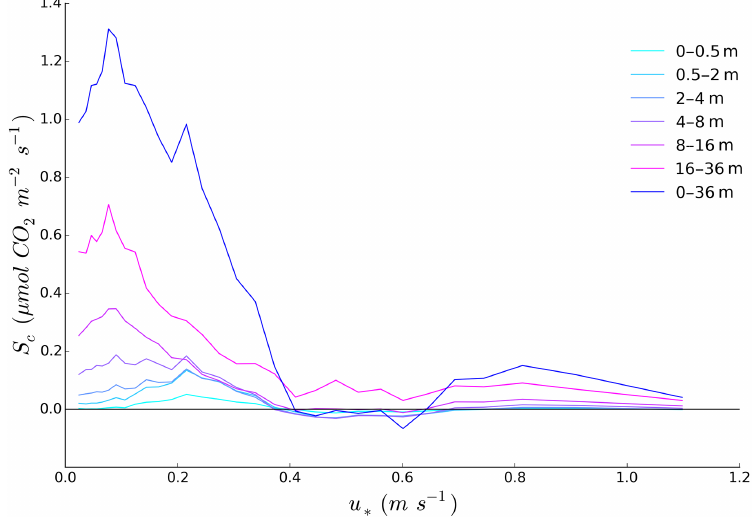
Figure 9. Dependence of measured storage components on friction velocity for individual